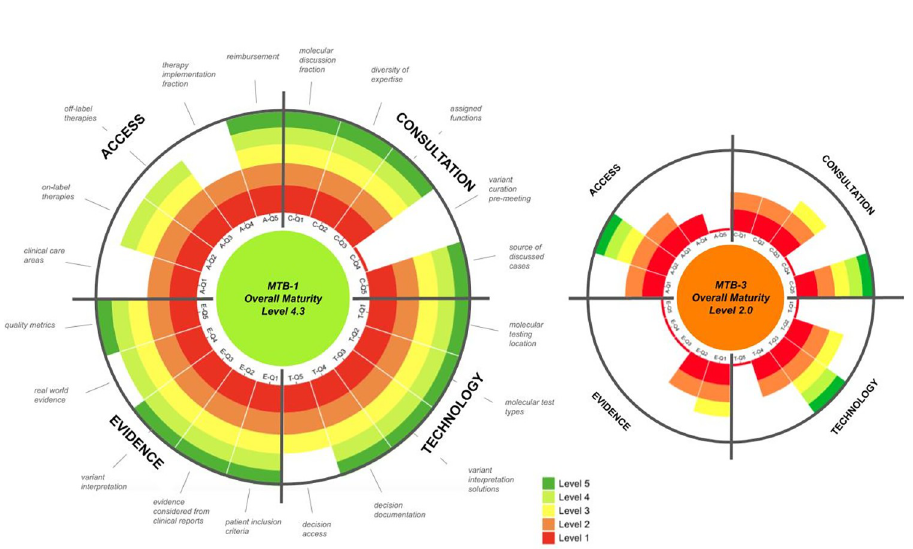
Fig 3. Radial plot of ACTE-MTB maturity assessments for highest and lowest maturity MTBs in Phase 2. Wedges in the radial plot represent individual survey questions with a small phrase provided at the top of each wedge to indicate the nature of the question. Each question is worth 5 points, with answers plotted on a “stoplight” color scale from Level 1 to 5. Overall maturity levels represent the average maturity score across the 4 categories, Access, Consultation, Technology, and